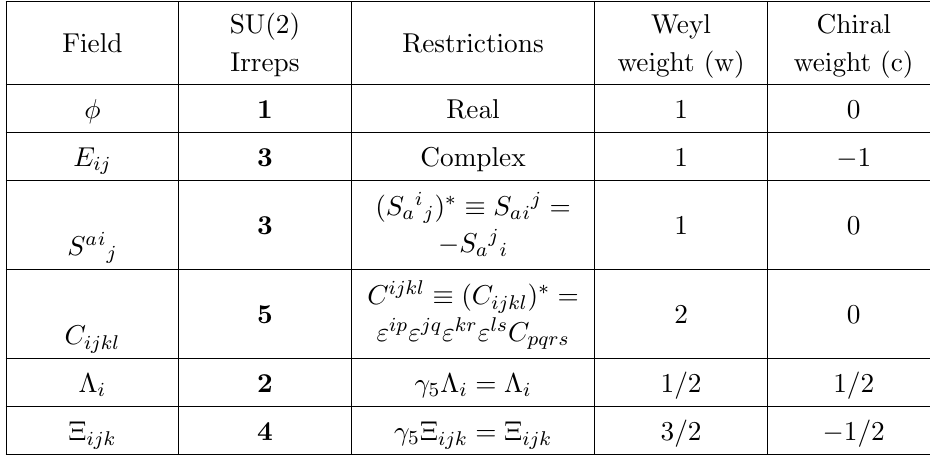
Table 1 . Field content of the N = 2 Real Scalar